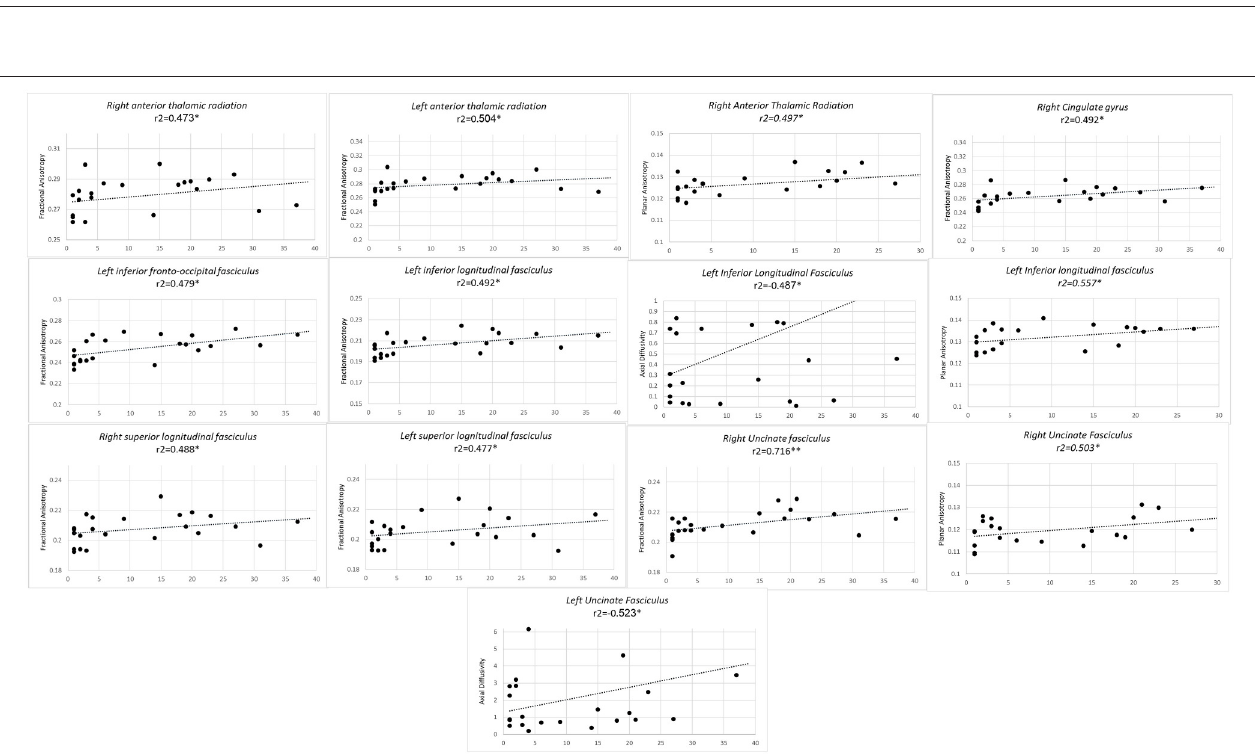
FIGURE 3 | Significant results from partial correlation analysis of diffusion metrics of Mori white matter atlas and chess player’s professional training time in years.